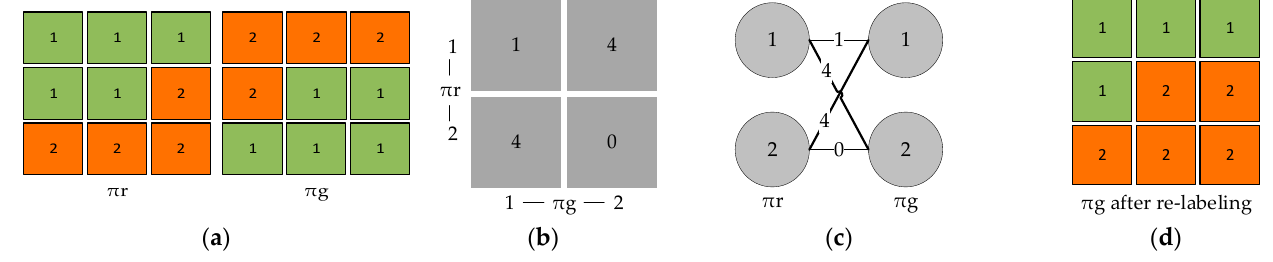
Figure 5. An example of cluster label unification. ( a ) To be re-labeled partition π g and the reference partition π r; ( b ) contingency matrix, and ( c ) the corresponding weighted bipartite graph (where maximum matchings are identified as bold edges); and ( d ) partition π g after re-labeling.